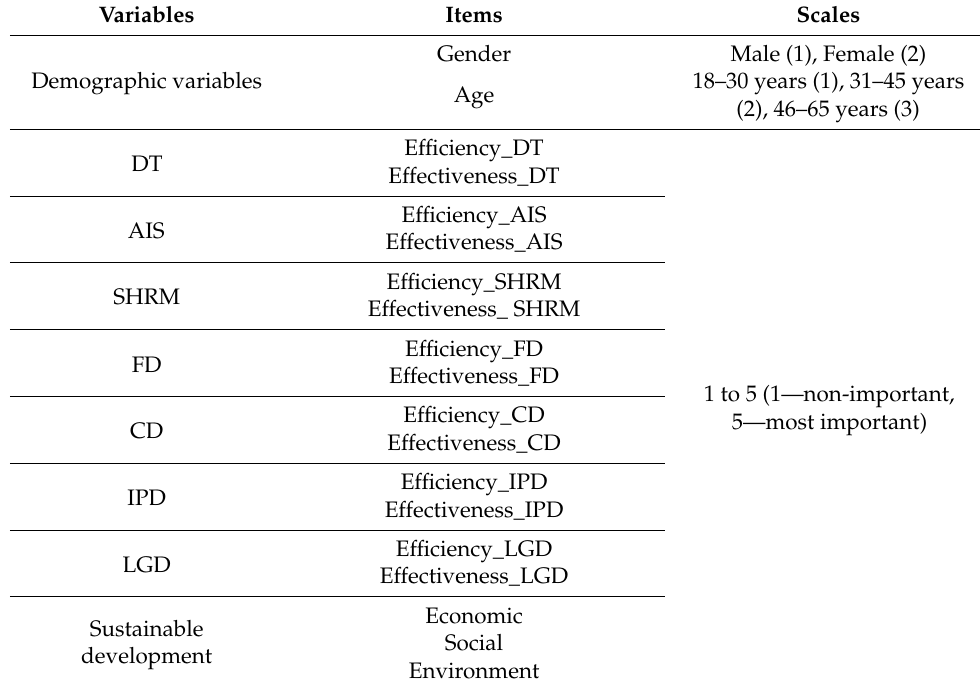
Table 1. Questionnaire design. Variables Items Scales Demographic